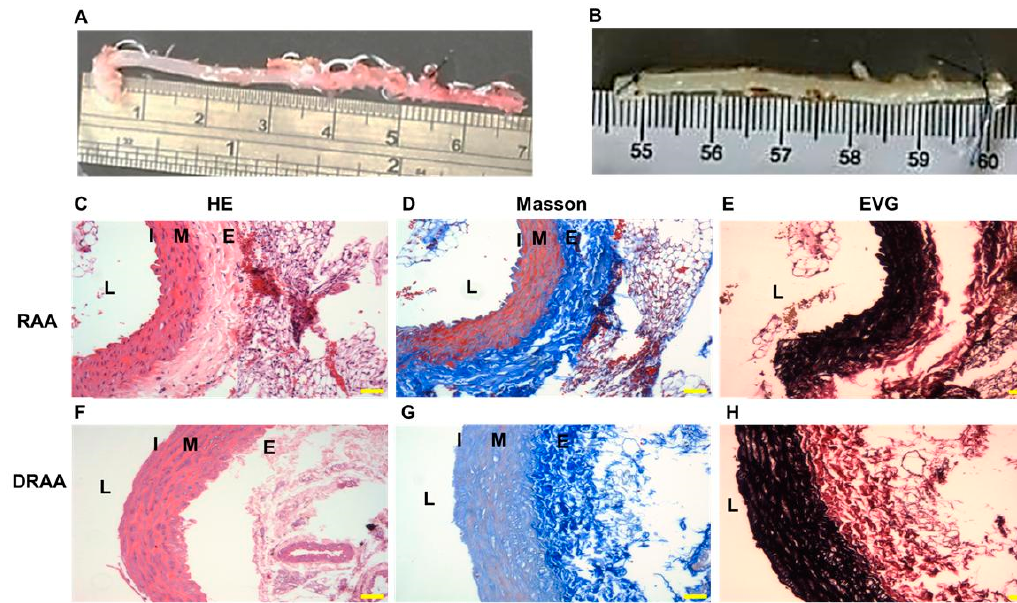
Figure 1. Gross appearance and histology of RAA and DRAA. ( A , B ) Gross appearance of the grafts